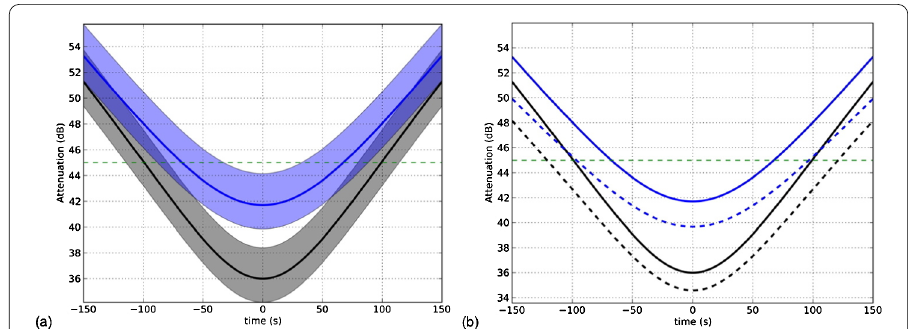
Figure 7 Link losses for two different orbital scenarios: ( a ) The lower (black) curve for a passage directly over the OGS and the upper (blue) curve for a ground track that passes at a distance of 500 km from the OGS. The solid curves give the losses for atmospheric turbulence characterized by a Fried parameter r 0 = 20 cm at 808 nm, whereas the shaded bands correspond to the range of 15 cm < r 0 < 25 cm. ( b ) The same as (a) for the solid curves, and in addition the corresponding curves for the link budget at 1550 nm (same atmospheric conditions, corresponding to r 0 = 44 cm at 1550 nm). The horizontal dashed line indicates the link loss limit of 45 dB for which the experiment duration that QKD would be possible is calculated